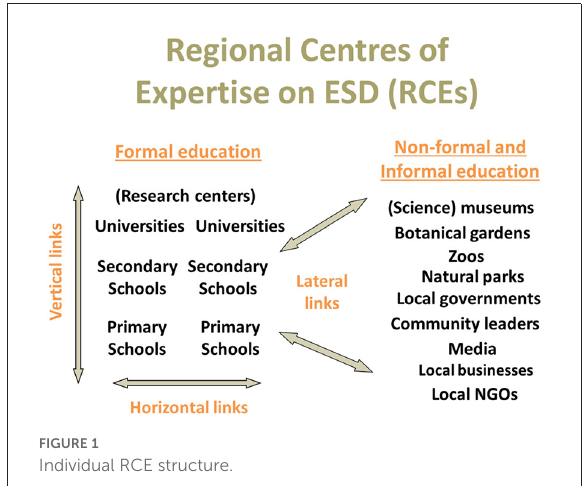
FIGURE1 Individual RCE